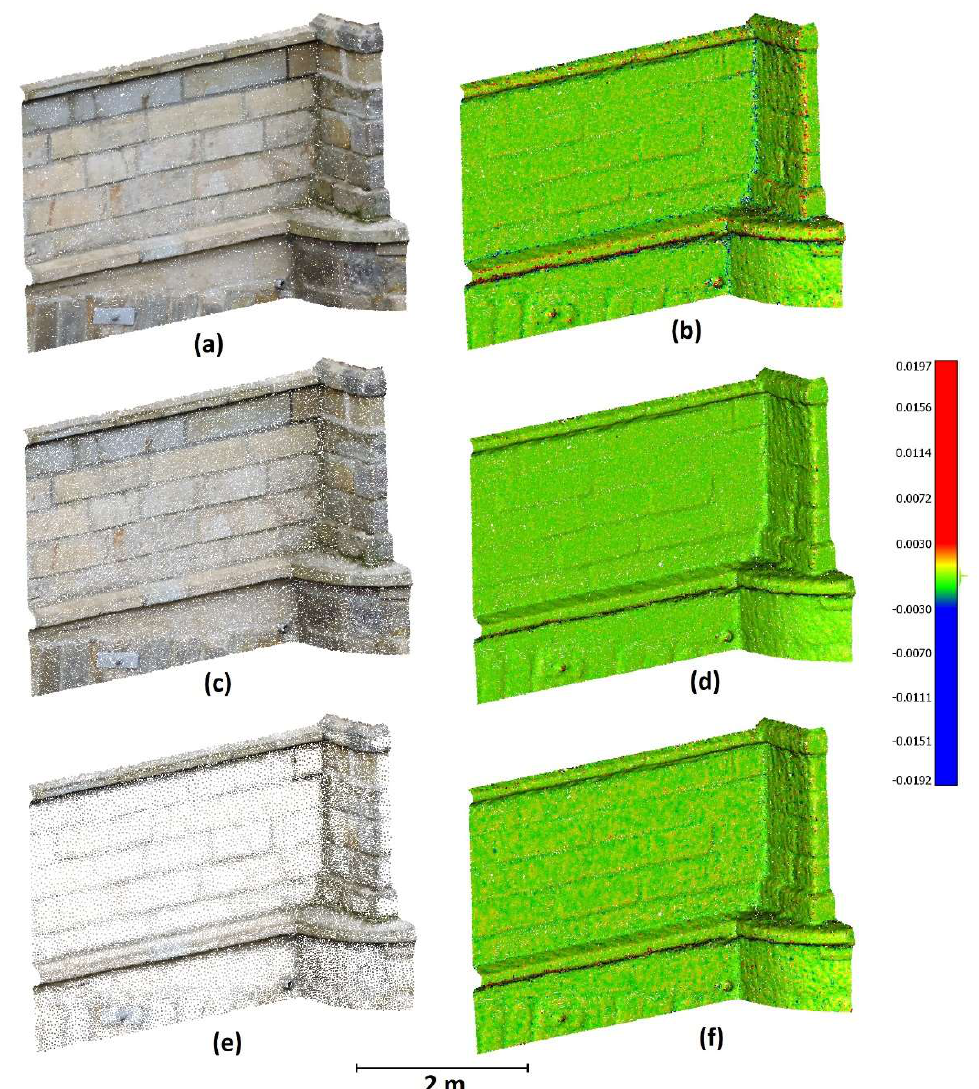
Figure 6. Details of the Data 1 point cloud: ( a ) original cloud, ( b ) differences between the cloud acquired by uniform dilution with a = 0.02 m and the original point cloud, ( c ) point cloud after uniform dilution with a = 0.01 m, ( d ) differences between the cloud acquired by uniform dilution with a = 0.01 m and the original point cloud, ( e ) point cloud after a = 0.01 m b = 0.05 m progressive dilution (approximately the same number of points in the cloud as for uniform dilution 0.02 m), ( f ) differences between the cloud acquired by progressive dilution with a = 0.01 m b = 0.05 m and the original point cloud. Note the higher representation of deviations on the edges of ( b ) compared to ( f ).